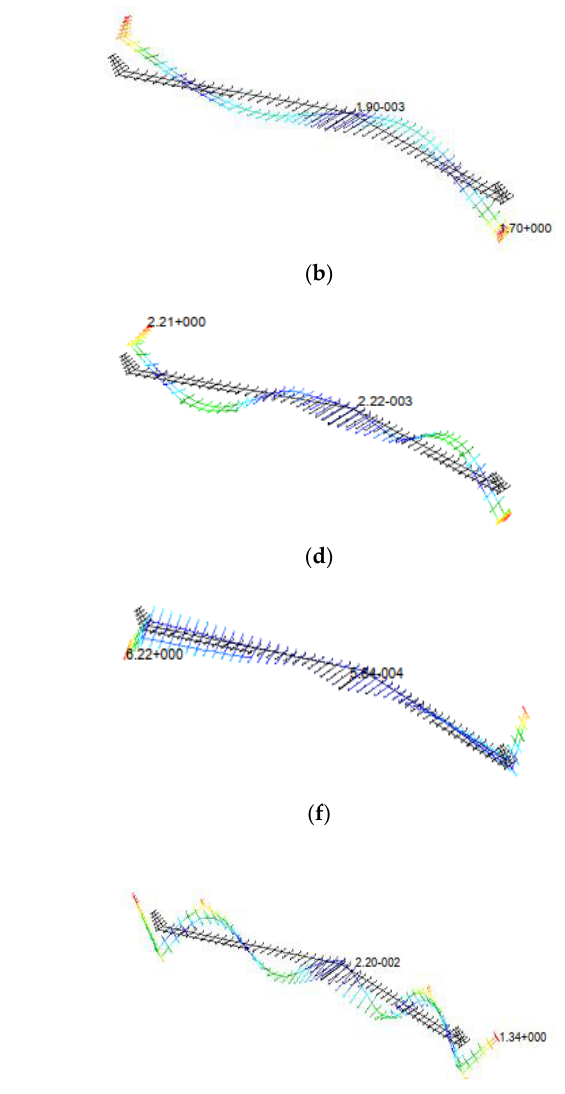
( c ) 2nd symmetric vertical bending. ( d ) 3rd asymmetric vertical bending. ( e ) 1st symmetric horizontal bending. ( f ) 1st asymmetric torsion. ( g ) 1st symmetric torsion. ( h ) 3rd symmetric vertical bending.